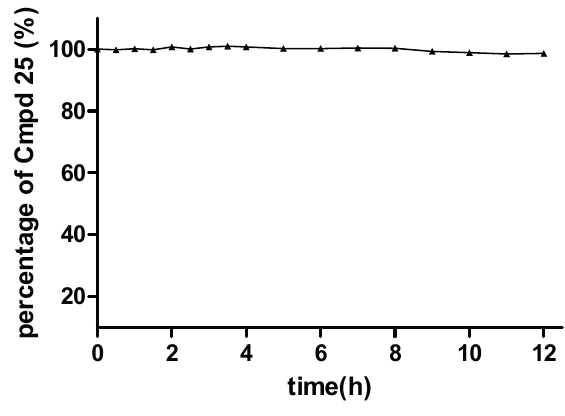
Figure 3. Stability of 25 under pH 7.4